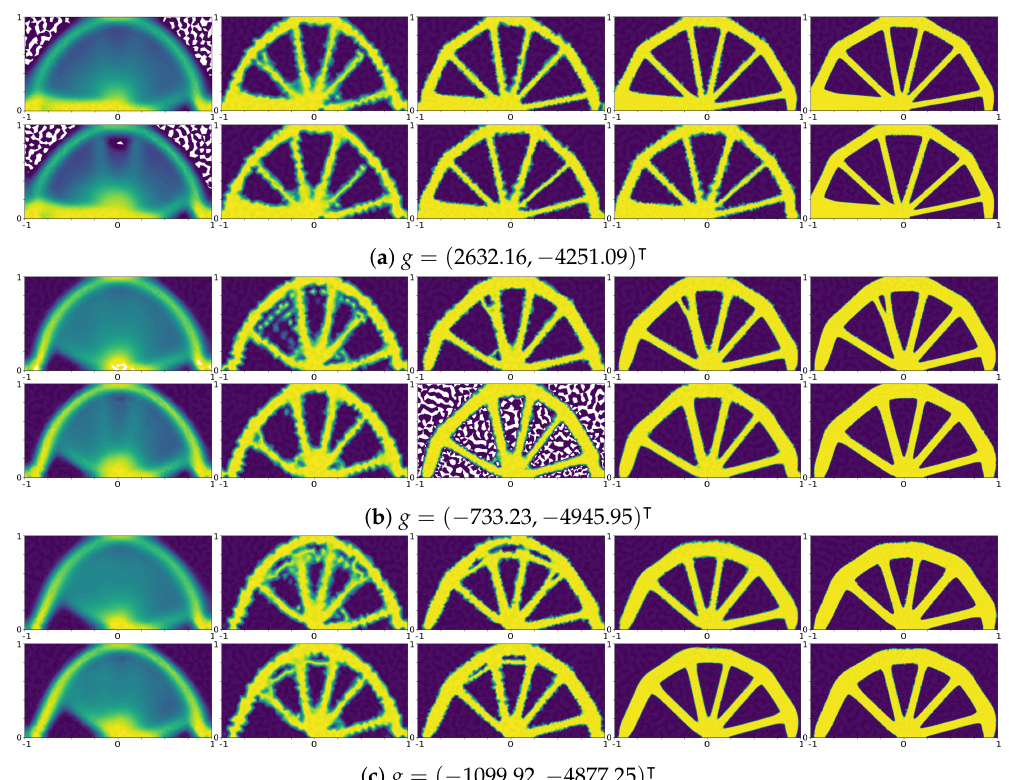
Figure 8. Comparison of metrics between Algorithms A1 ( top row ) and 1 ( bottom row ) for different loads g